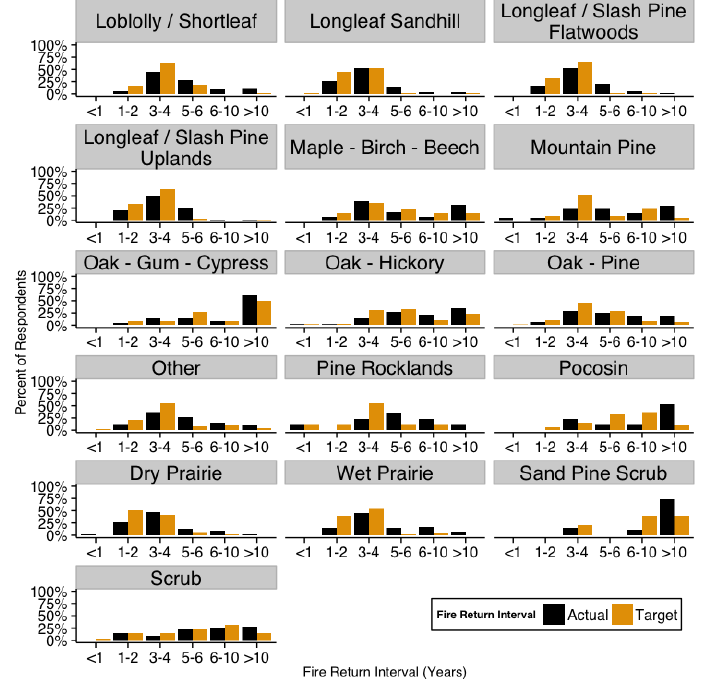
Figure 3. Targeted vs. actual reported fire return intervals by community type, including all responses regardless of state or